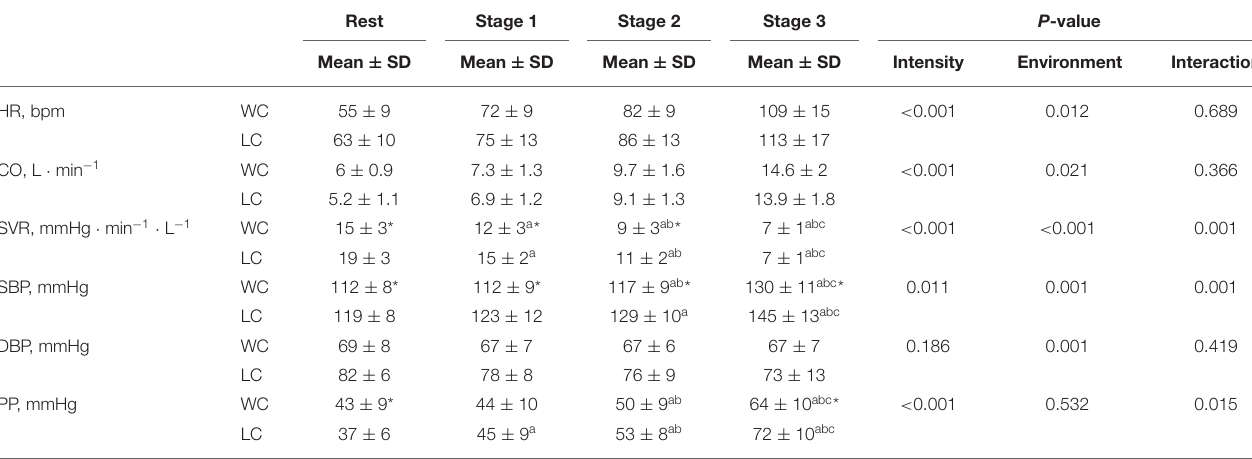
TABLE 2 | Systemic hemodynamics at rest and during